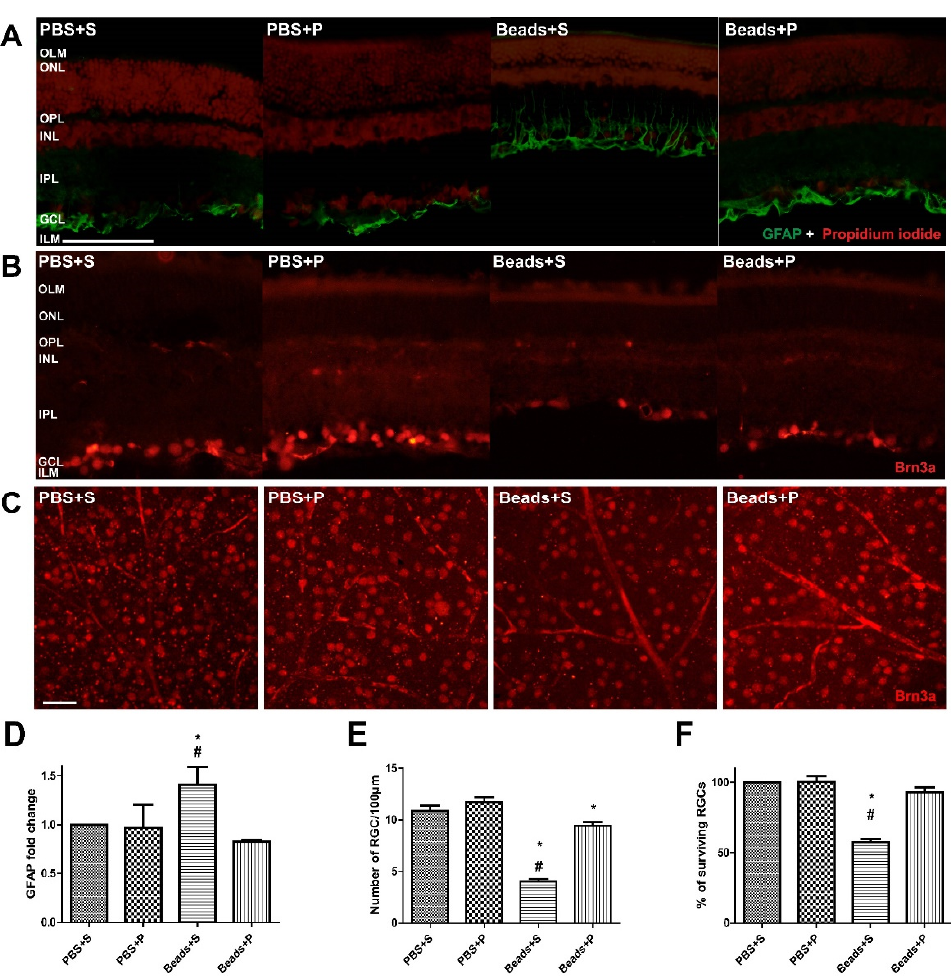
Figure 3. Representative vertical retinal sections ( A , B ) and whole-mount (retinal areas within 2 mm from the optic nerve) ( C ) stained by GFAP ( A ) and Brn3a ( B , C ) antibodies showing the effects of elevated IOP in the four examined groups (PBS + S, PBS + P, Beads + S, Beads + P). IOP resulted in massive elevation of GFAP immunopositivity ( D ), and reduction of Brn3a expression ( E , F ) in Beads + S group compared to the controls (PBS + S, PBS + P) and the PACAP1-38-treated (Beads + P) retinas. Statistical comparisons were made using ANOVA followed by Fischer’s (GFAP, Brn3a whole-mount) and Bonferroni’s (Brn3a section) post hoc analysis. Data are presented as means ± SEM. * Beads + S vs. PBS + S and Beads + P vs. PBS + P p < 0.05; # Beads + S vs. Beads + P p < 0.05. Bar: A, B: 50 µ